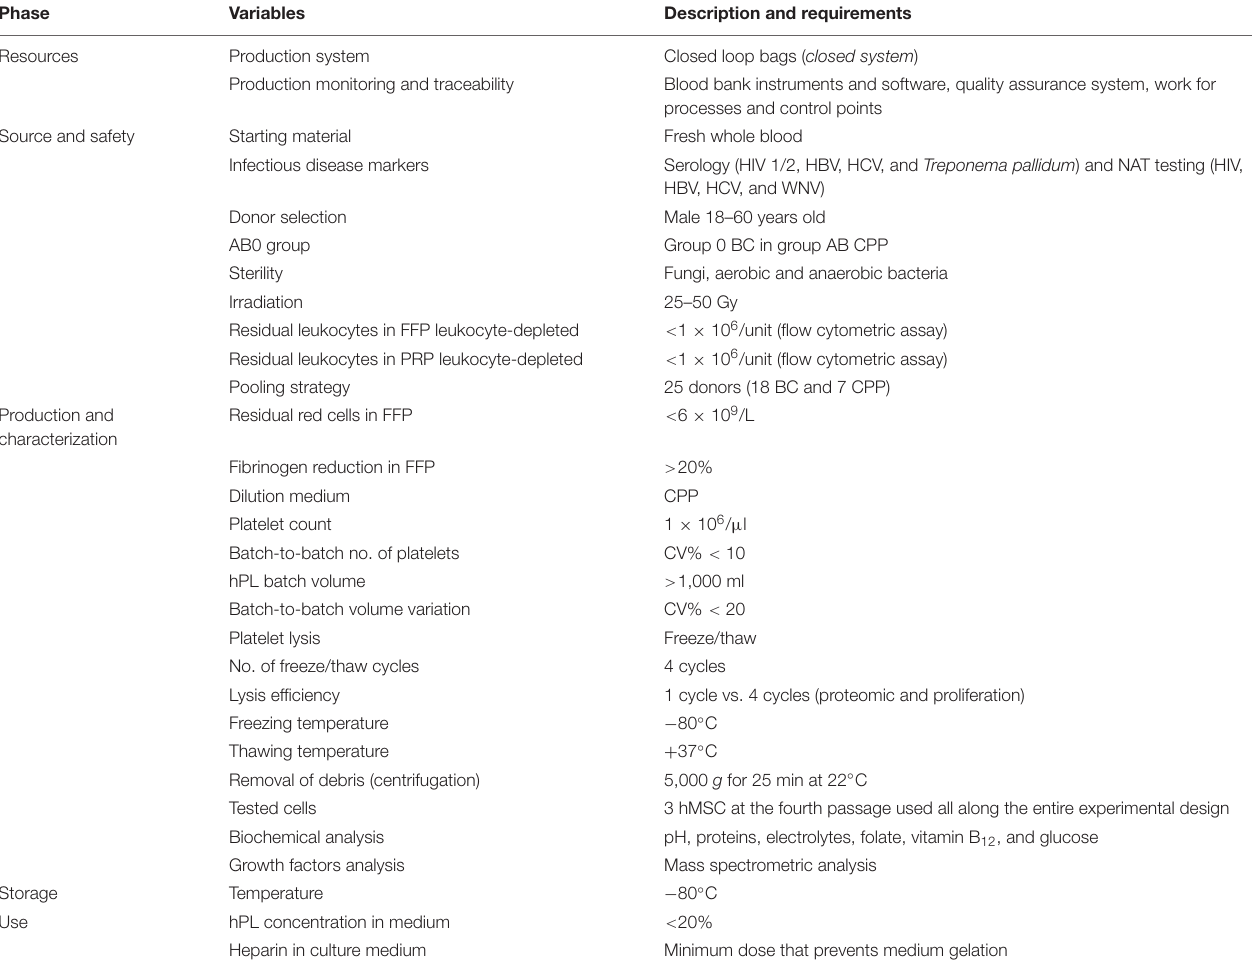
TABLE 1 | Definition of variables and requirements considered in Brescia Blood Bank hPL production